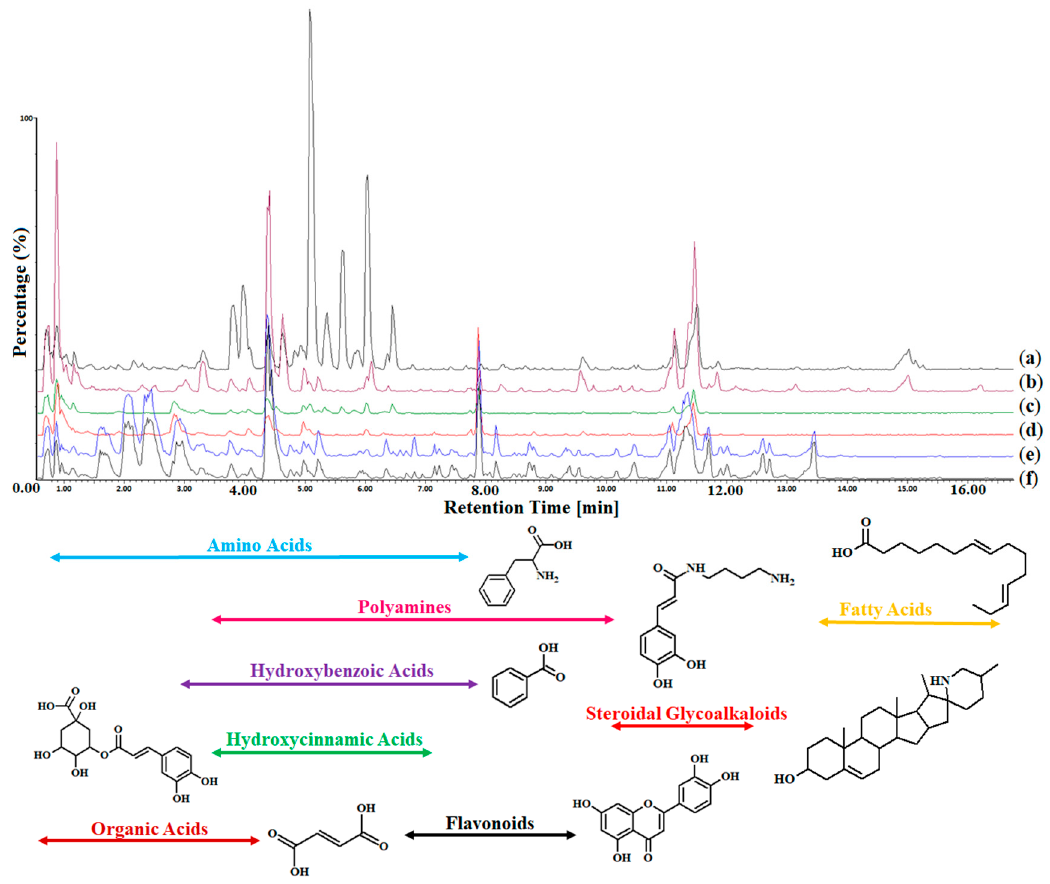
Figure 1. A representative ultrahigh-performance liquid chromatography-mass spectrometry (UHPLC-MS) base peak intensity (BPI) chromatogram (ESI( − ) mode) overlay showing the metabolite profiles of tissues from the Solanum lycopersicum cultivar “1R” before and after treatment with R. solanacearum. ( a ) The 1R treated root sample. ( b ) The 1R control root sample. ( c ) The treated 1R stem sample. ( d ) The 1R control stem sample. ( e ) The 1R treated leaf sample. ( f ) The 1R control leaf sample. The y-axis represents the relative abundance (%) of the metabolite fragments at their respective retention times (min). A secondary metabolite belonging to each metabolite class is shown below the BPI overlay.